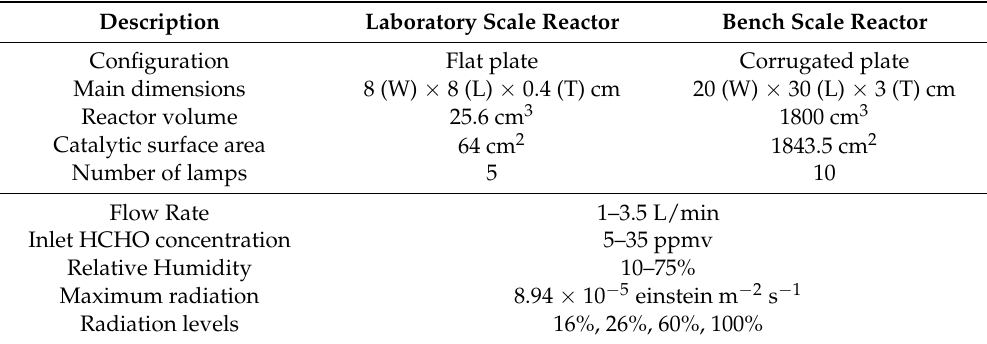
Table 1. Main characteristics of reactors and operating conditions.